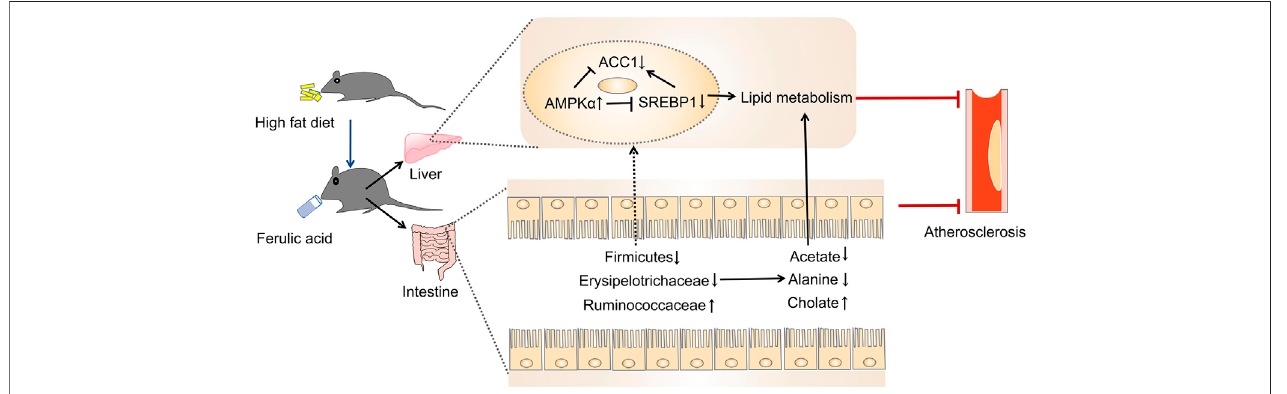
FIGURE 10 | The proposed mechanism for FA reducing atherosclerosis injury in ApoE − / − mice (Huang et al., 2019).